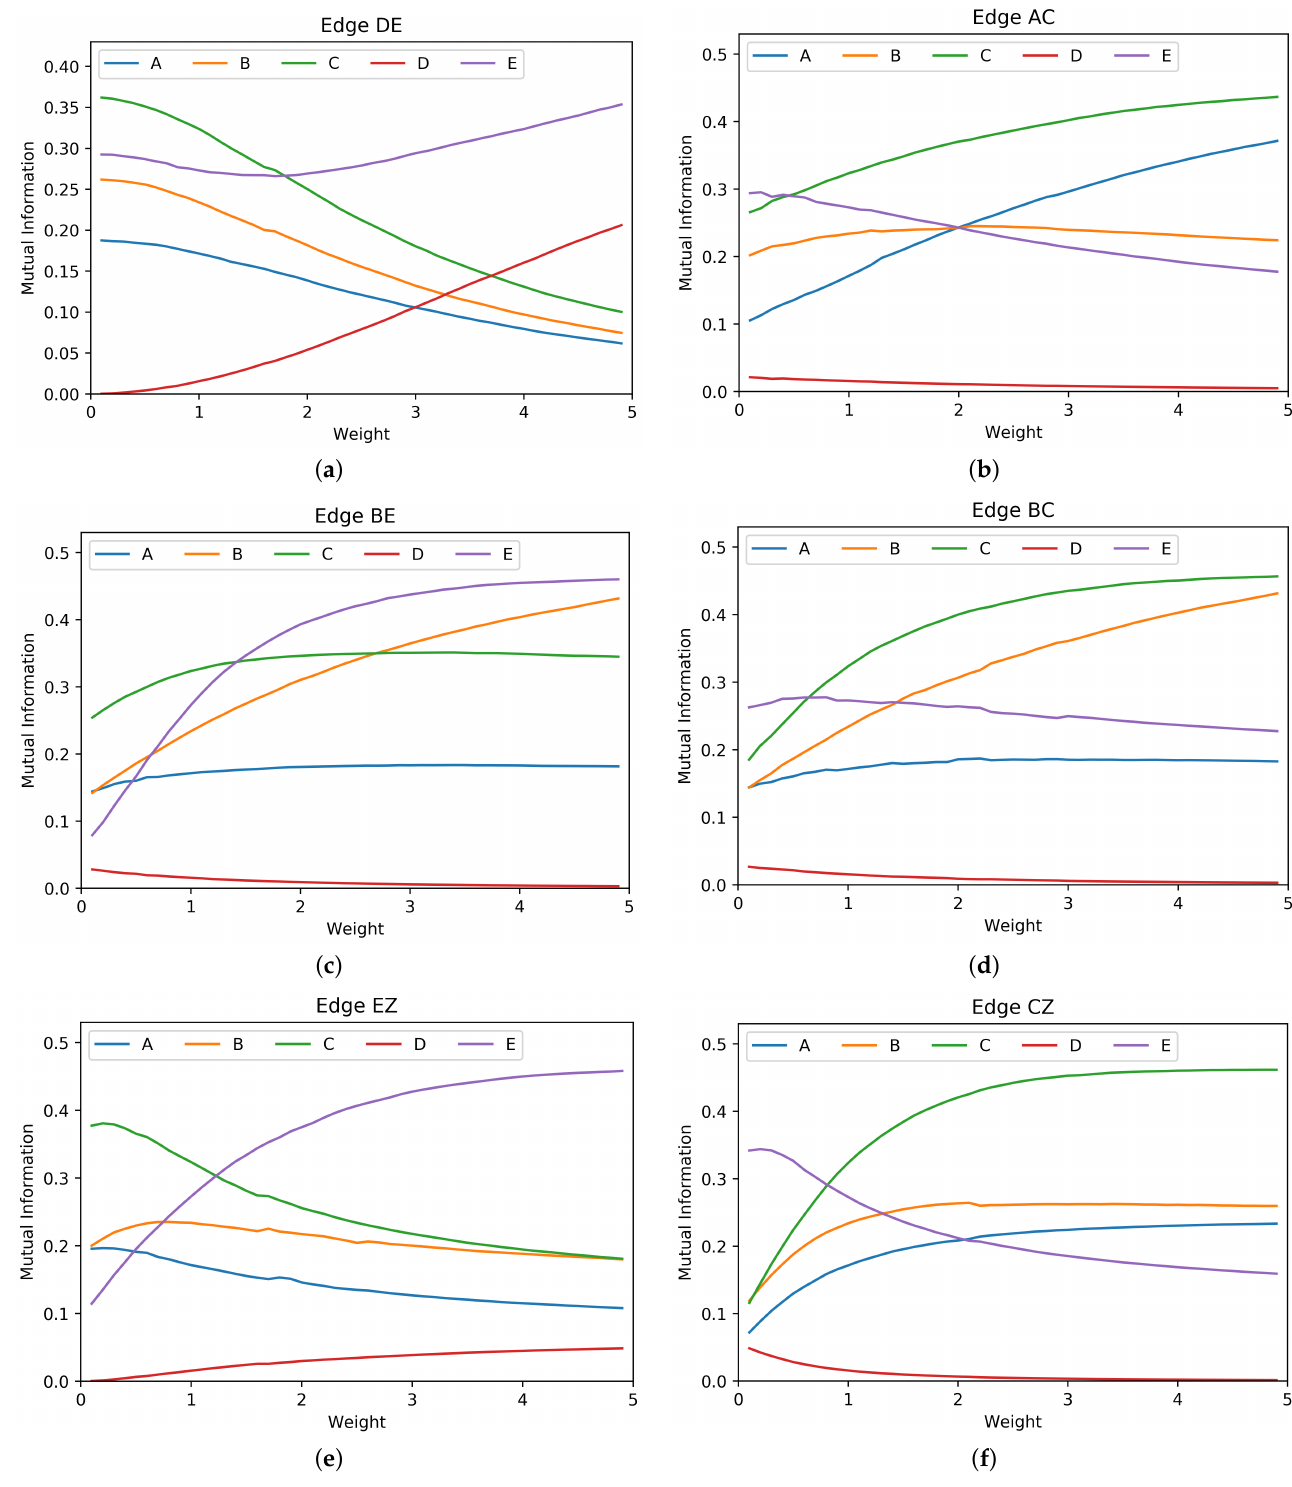
Figure 5. Mutual information between node Z and each other node, varying edges weight. ( a ) M.I. as function of edge DE weight. ( b ) M.I. as function of edge AC weight. ( c ) M.I. as function of edge BE weight. ( d ) M.I. as function of edge BC weight. ( e ) M.I. as function of edge EZ weight. ( f ) M.I. as function of edge CZ